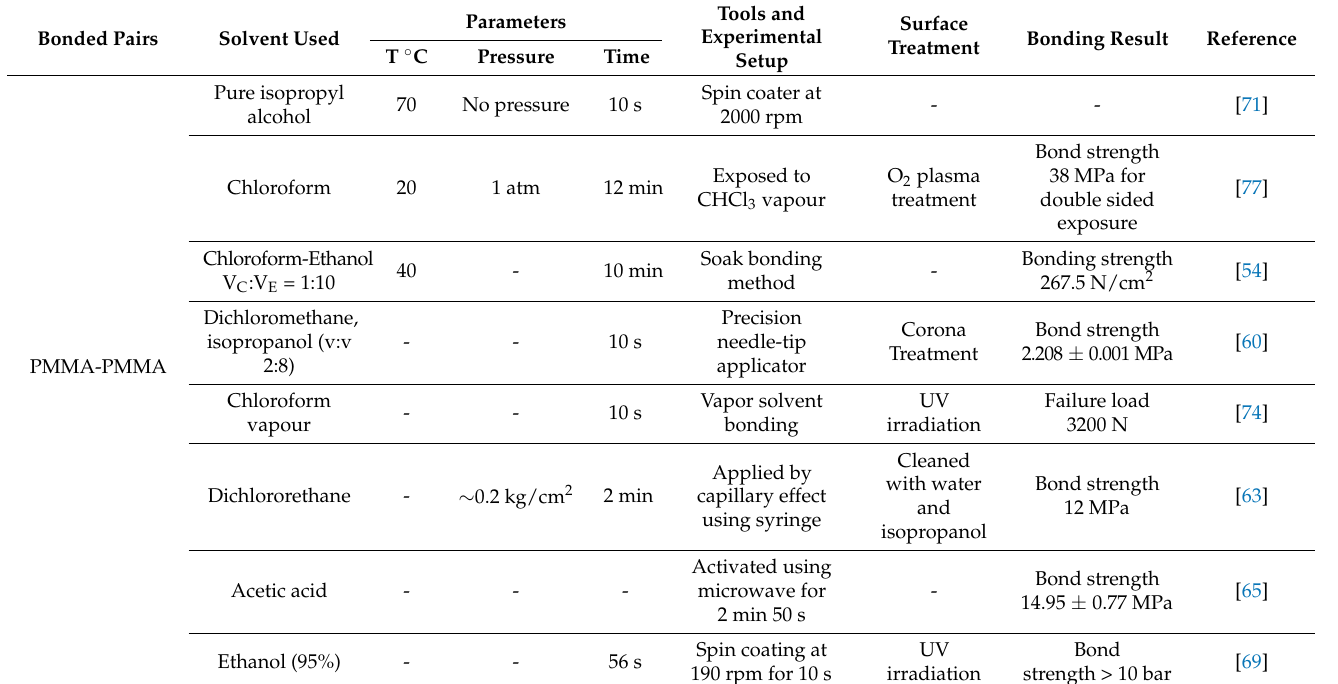
Table 3. Solvent bonded pairs, solvent used, parameters, tools required, surface treatment and bonding